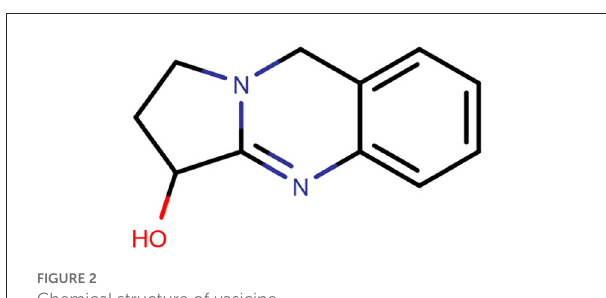
FIGURE2 Chemical structure of